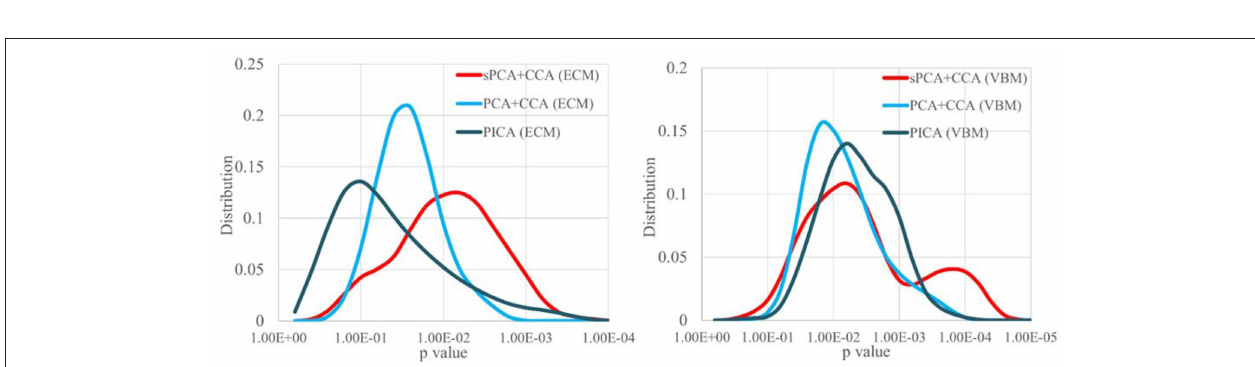
FIGURE 8 | The distribution of p -values for group discrimination with the number of principal components ranging from 4 to 20. VBM dataset has more significant p -value than ECM dataset. The sPCA + CCA method has more significant group discrimination than PCA + CCA and parallel ICA.